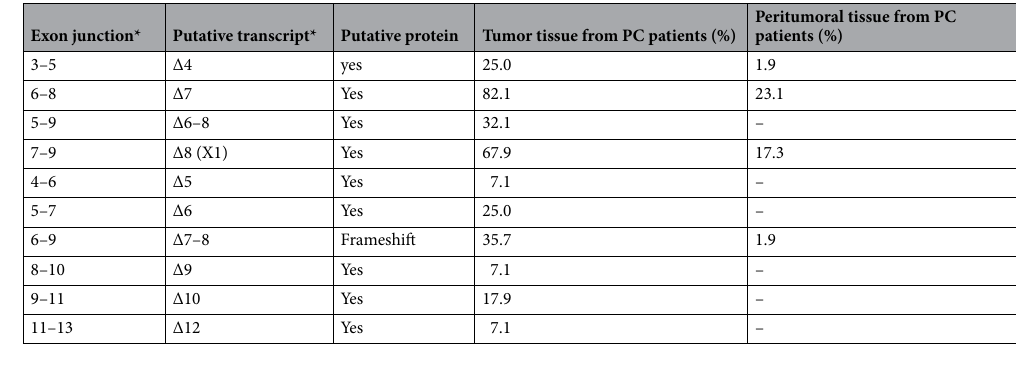
Table 4. ETV4 transcripts with exon skipping found in tumor and peritumoral samples of prostate carcinoma patients from TCGA dataset. *Exon junctions (and their associated putative transcripts) found in the tumor tissue of at least 2 patients with a total of more than 20 reads. Of note the number of reads of these selected exon junctions in peritumoral tissues was ≤ 18 (range